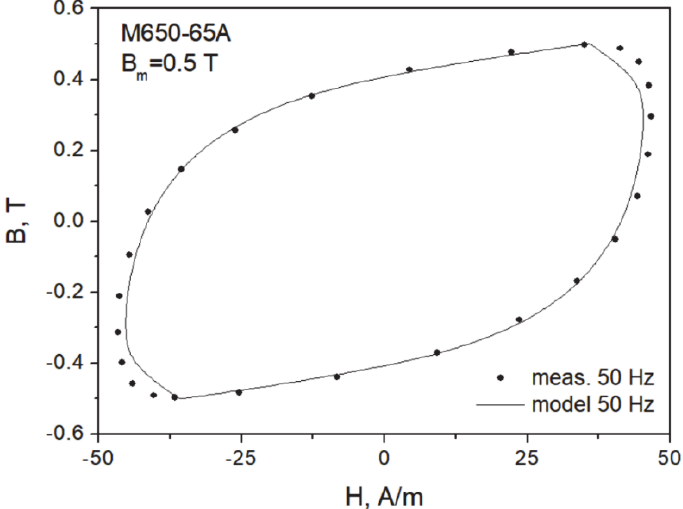
Figure 9. Measured and modeled hysteresis loop for Bm = 0.5 T, f = 50 Hz, M530 ‐ 65A grade.